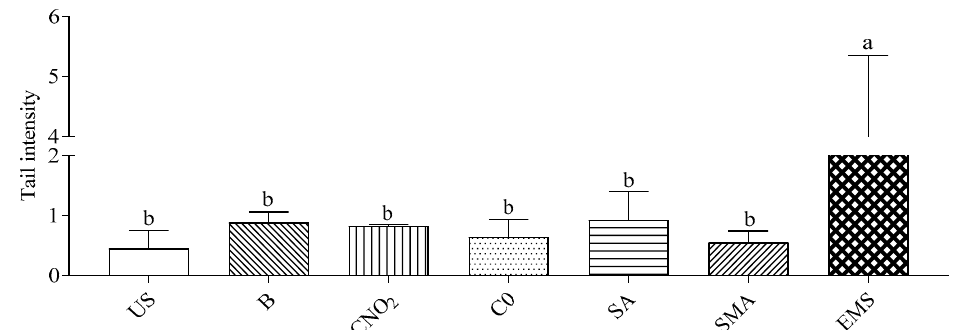
Figure 4. Genotoxic effect of different salami formulations. Data are means ± SD of three independent supplementation of in vitro digested, each one analyzed in triplicate. The genotoxicity is expressed as tail intensity. Statistical analysis was by one-way ANOVA ( p < 0.05) with Tukey’s post-hoc test comparing unsupplemented (US), 2 mM ethylmethanesulfonate (EMS) and digested supplemented cells (different letters indicate significant differences). B: “blank” digestion; C-NO 2 : salami with sodium nitrite, potassium nitrate and with nitrate-reducing microbial starter cultures; C-0: salami containing neither nitrate-reducing microbial starter cultures nor additives (nitrite, polyphenols and ascorbate); SA: salami with nitrate-reducing microbial starter cultures and sodium ascorbate; SMA: salami with nitrate-reducing microbial starter cultures, sodium ascorbate and plant extracts.